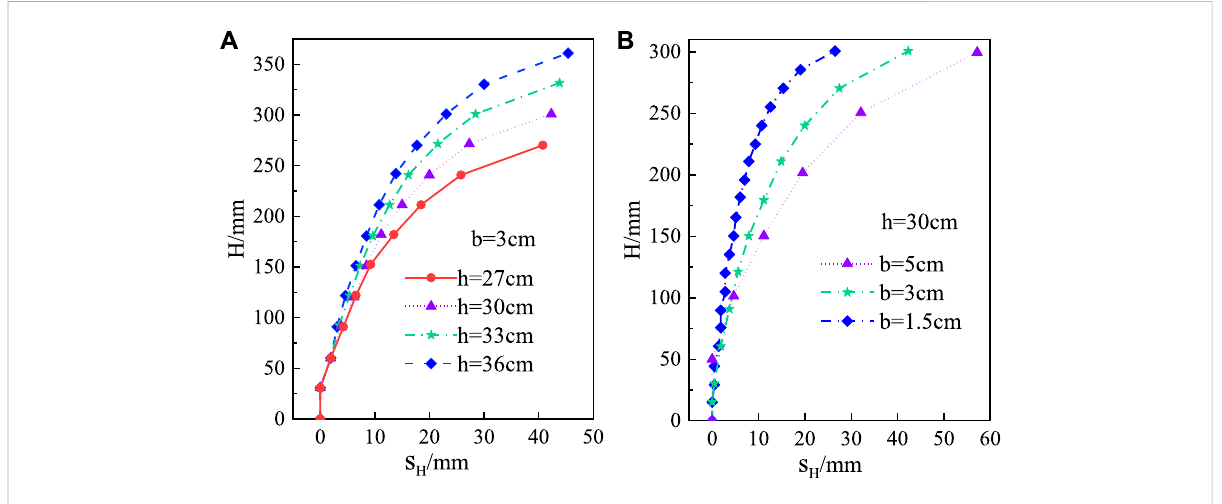
FIGURE 15 Displacement variation of rock blocks of the translational motion in the limit equilibrium state. (A) Different stacking heights of rock blocks. (B) Different rock block sizes.